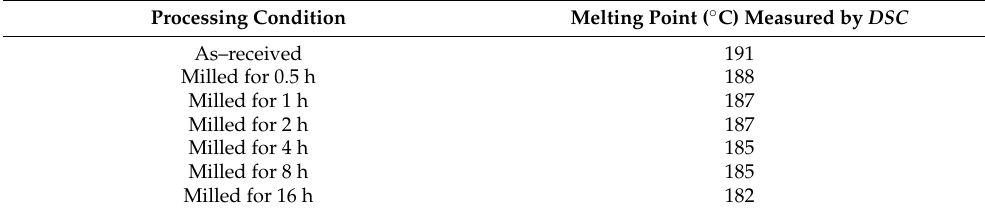
Table 6. Melting temperature values obtained by Differential Scanning Calorimetry ( DSC ) for each sample of PVA.